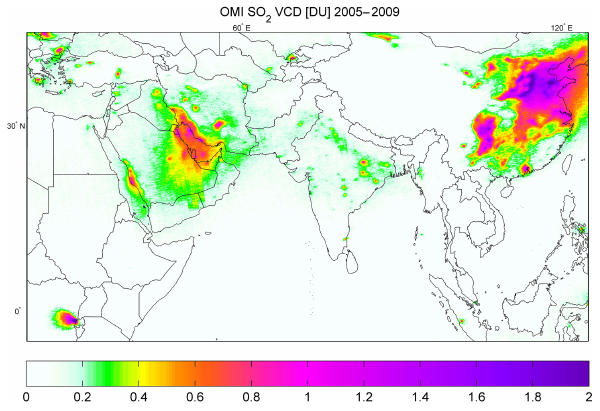
Figure 1. Map of averaged SO 2 columns from OMI clear-sky pixels for the 2005–2009